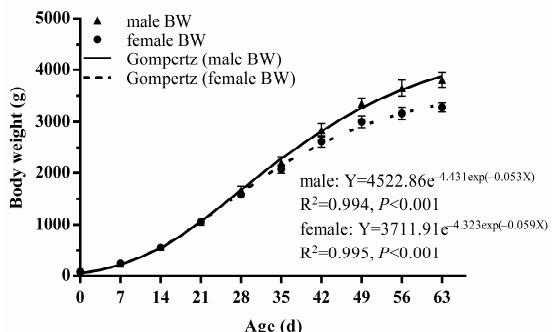
are shown in Table 3. The inflection point ages of breast muscle weights in males and females were 54.35 d and 56.7 d, and fast-growth intervals were 46.10 to 64.91 d and 45.20 to 69.15 d, respectively. The inflection point ages of leg muscle weights in males and fe- males were 25.49 d and 27.67 d, and fast-growth intervals were 9.71 to 41.26 d and 16.59 to 35.58 d, respectively. As shown in Figure 3C, the leg muscle of goslings grew synchro- nously with their BW, while the growth of the breast muscle lagged behind the leg muscle and BW. Figure 1. The observed body weight and Gompertz model growth curve of male and female goslings from hatching to 63 d of age. The observed body weight is the mean and standard deviation (n = 8). Table 3. Estimated values of body weight, muscle mass, and tibia traits using the non-linear model 1.